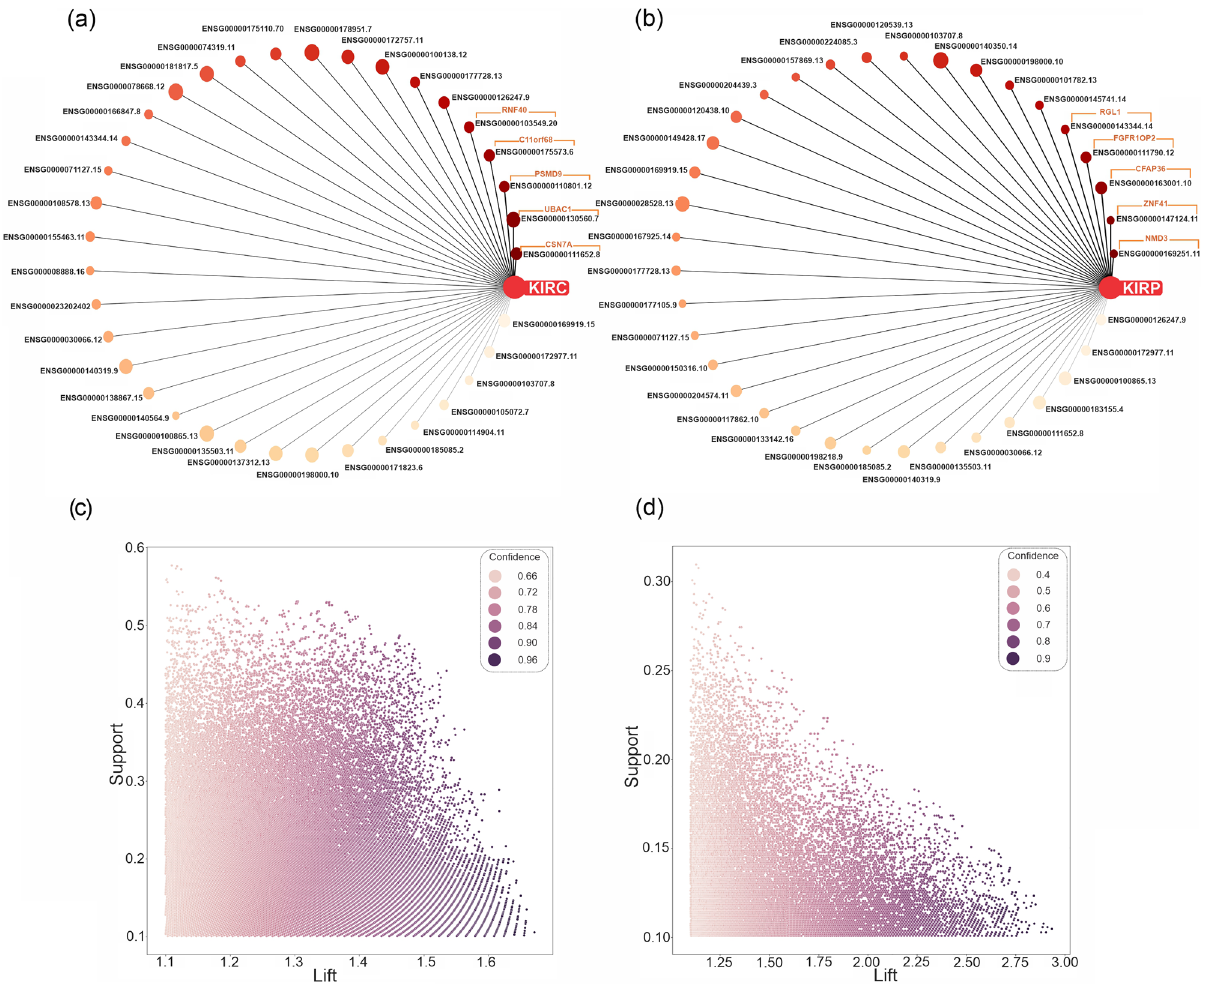
Figure 5. The KIRC/KIRP association rules in the mRNA data. Graph network of ( a ) KIRC and ( b ) KIRP association rules of top mRNAs with a high repeat count. The most frequent mRNAs were displayed with the weight of the edge based on repeat counts. The mRNAs’ AMGM value is illustrated with the size of the node. Strength distribution of ( c ) KIRC and ( d ) KIRP association rules according to their support, lift, and confidence. KIRC kidney renal clear cell carcinoma, KIRP kidney renal papillary cell carcinoma, KICH kidney chromophobe